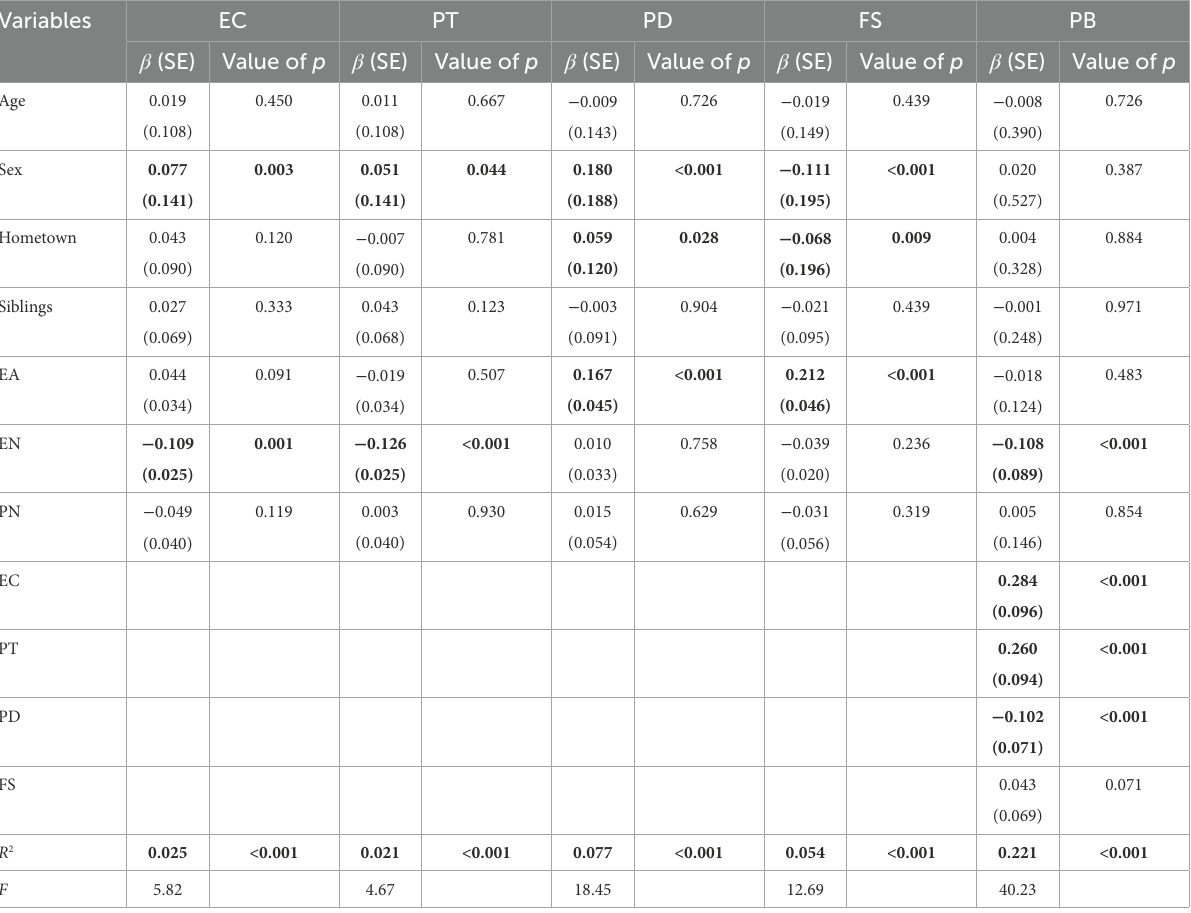
TABLE 3 Standardized coefficient estimates predicting empathic concern, perspective-taking, personal distress, fantasy, and prosocial behavior ( N = 1,569).